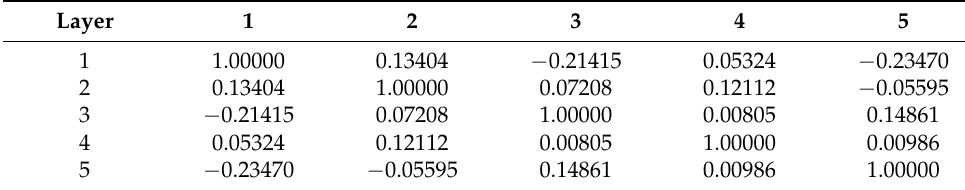
Table 1. Correlation matrix.